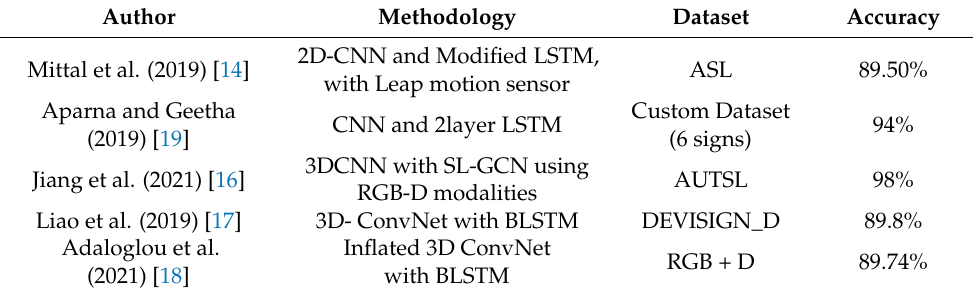
Table 1. Comparative analysis of various deep learning